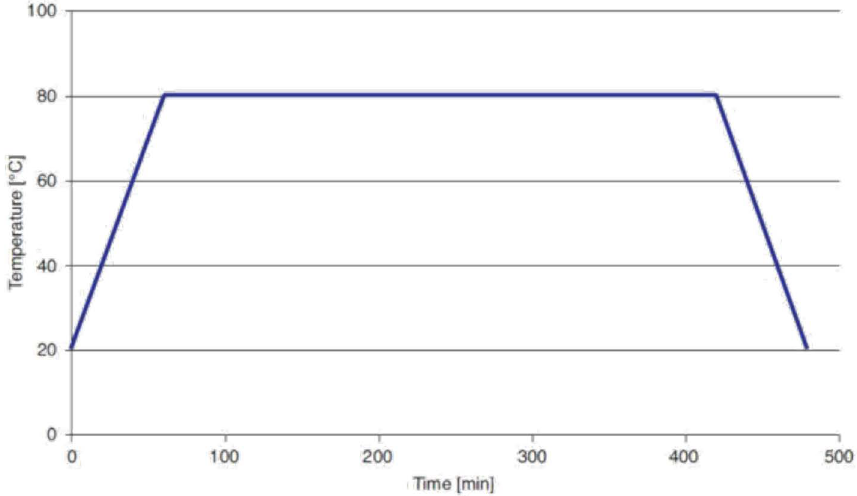
Figure 5. Polymerization cycle for composite specimen